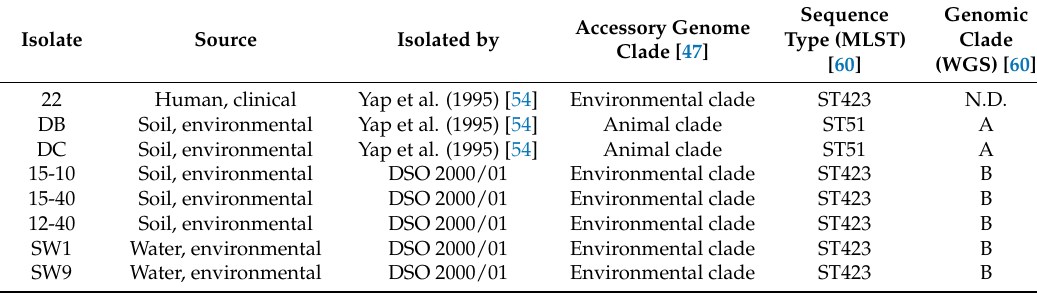
Table 5. Correlation of clinical and environmental B. pseudomallei isolates from an island off Singapore [61].